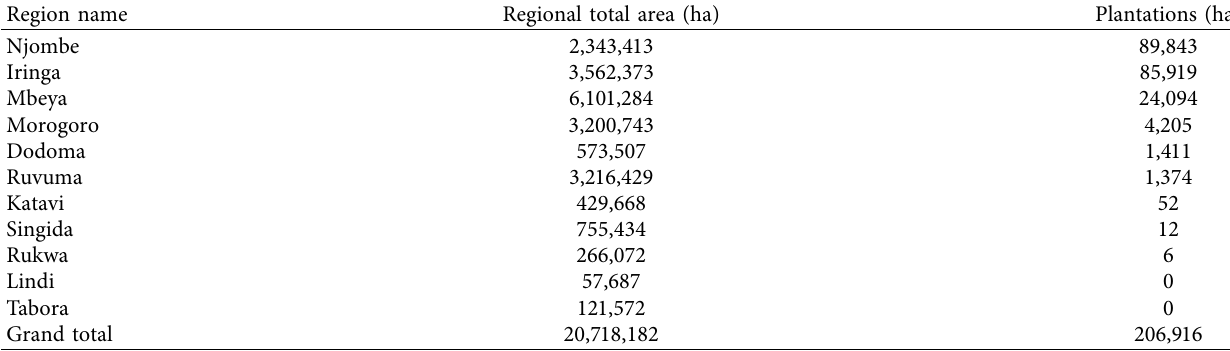
Table 1: List of forest plantations in Southern Highlands,